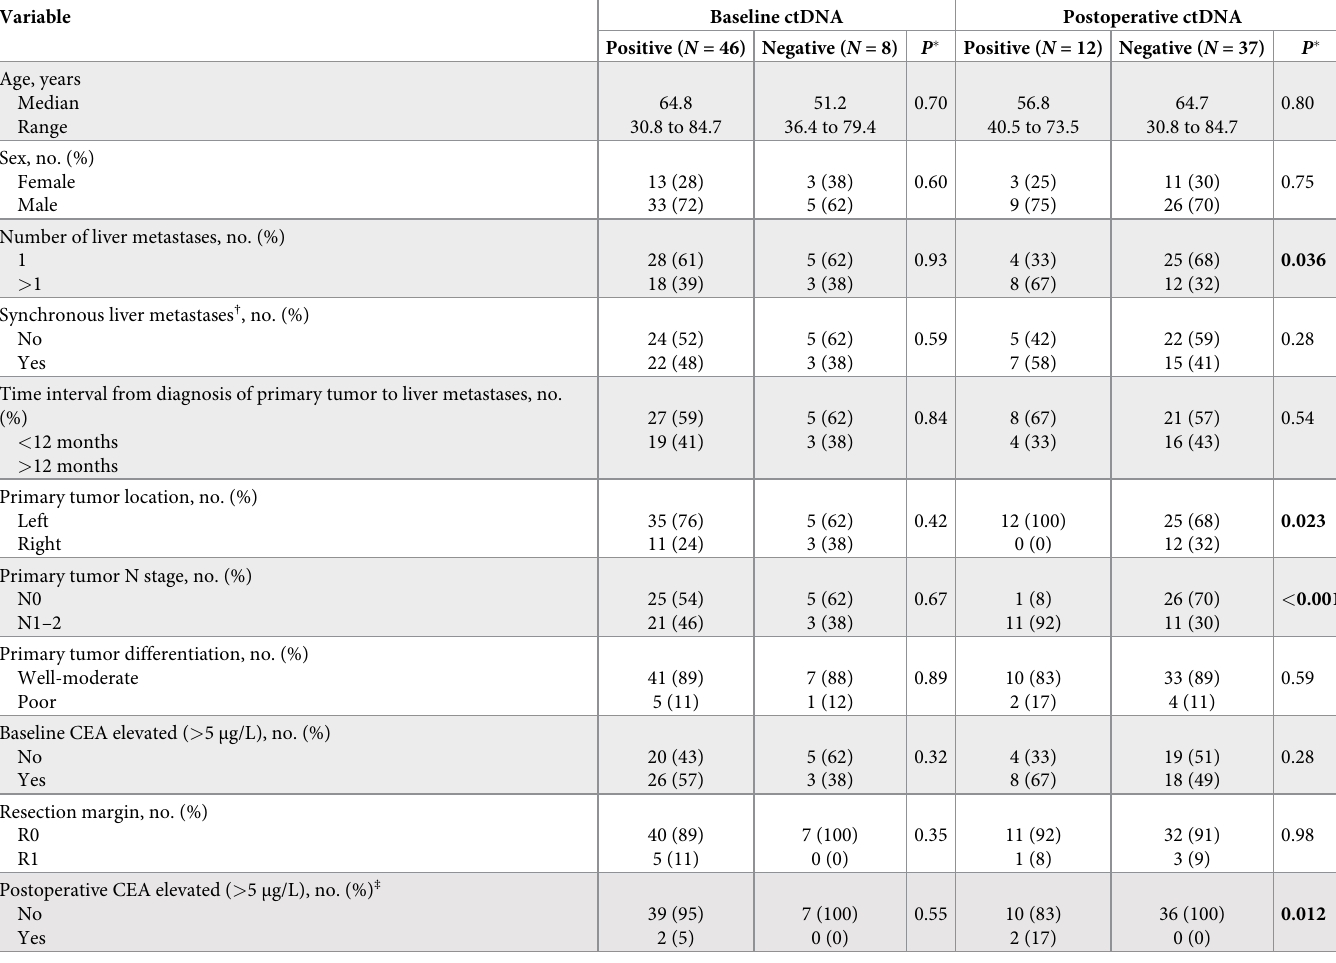
Table 1. Clinicopathological features, baseline ctDNA, and postoperative